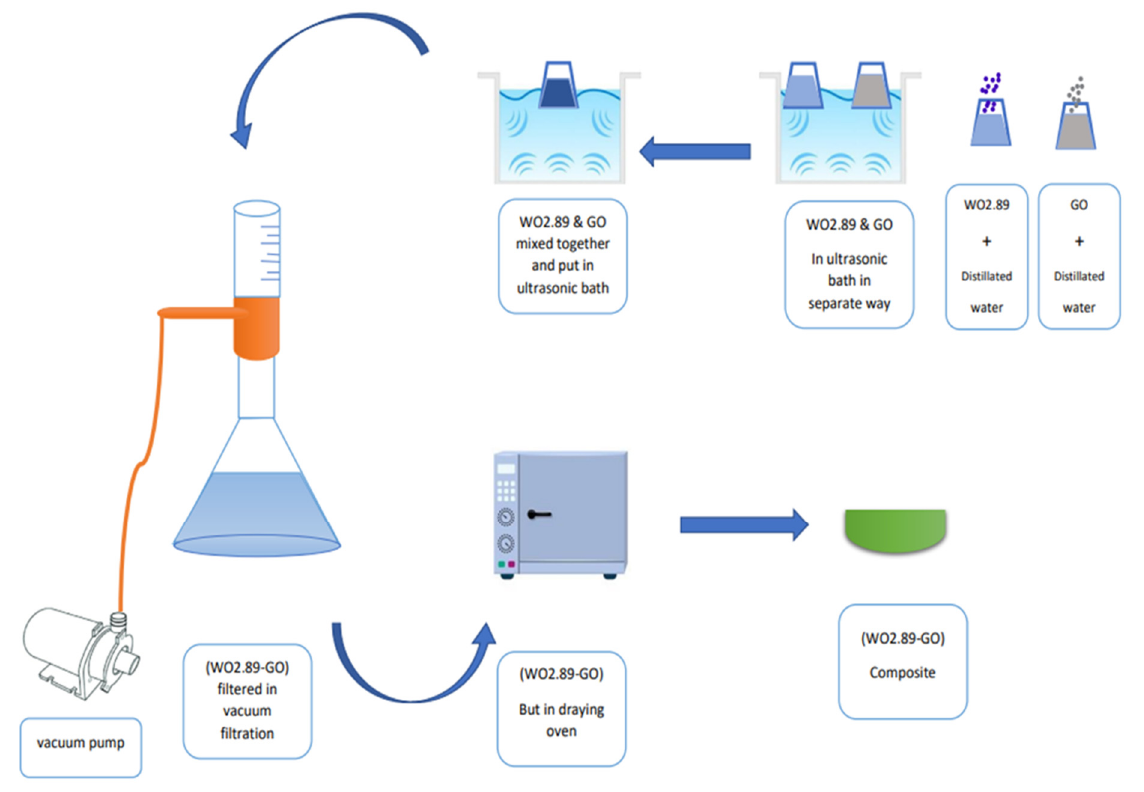
Figure 2. Scheme of manufacturing process of nanocomposite (WO 2.89 -GO). Table 1. Composition of polymer, additives, and solvent for membrane